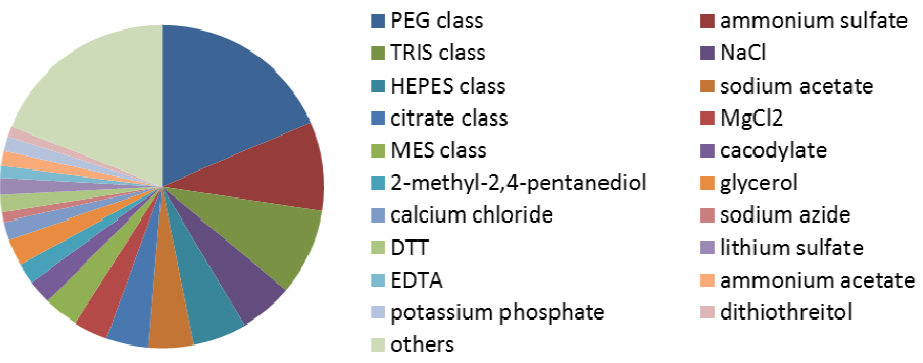
Figure 1. The main crystallization reagents and their frequencies in the non-redundant dataset from the Biological Macromolecule Crystallization Database